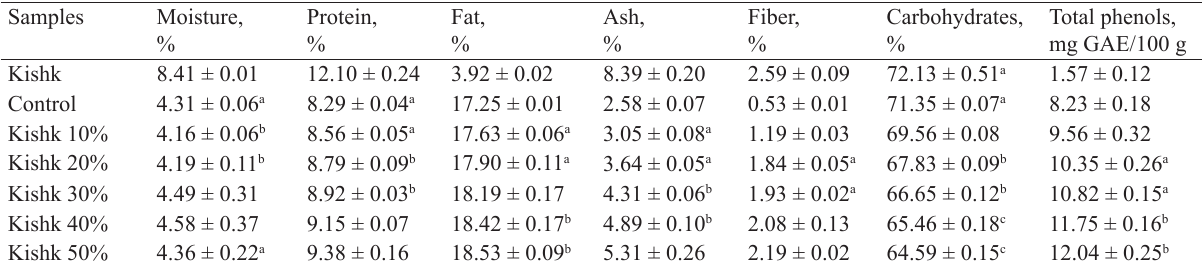
Table 2 Nutritional composition of Egyptian kishk and biscuit fortified with kishk Samples Moisture, %